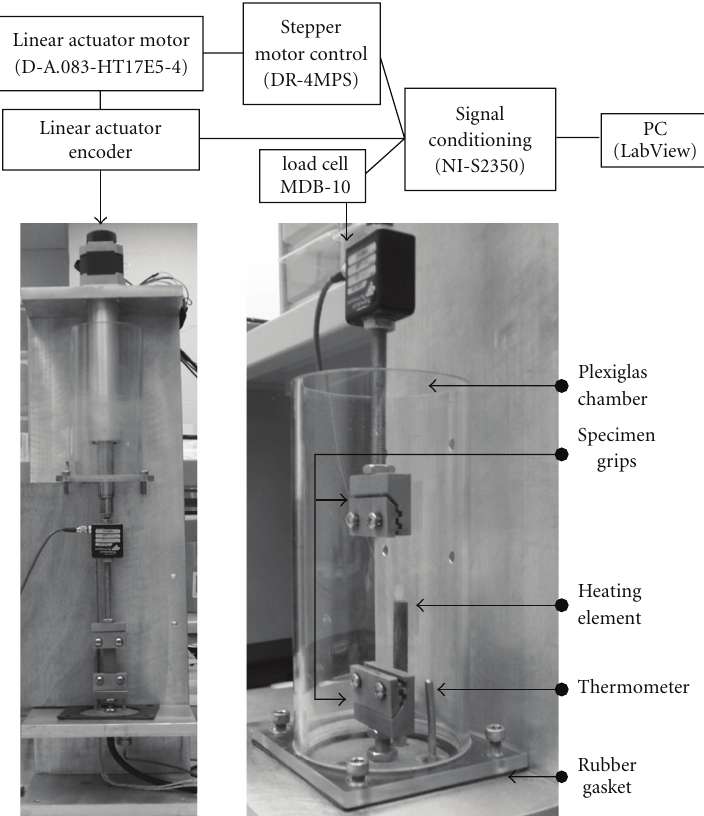
Figure 3: Uniaxial tensile system components and controllers.